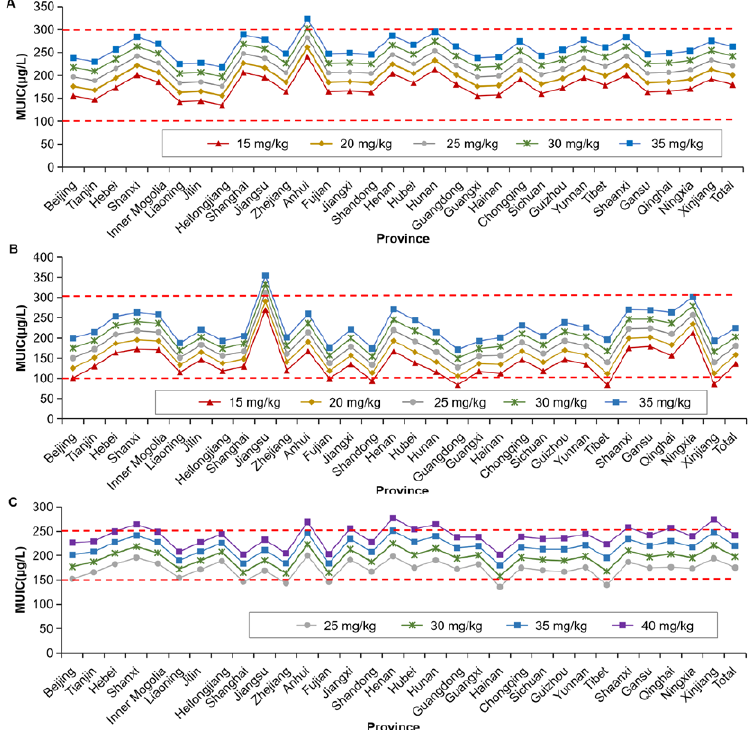
Figure 5. Evaluation by median urinary iodine concentration standard for children, adults and pregnant women under condition of the presumed different iodine content in salt. ( A ) for children; ( B ) for adults; ( C ) pregnant women. When the iodine content in salt was set as 20 mg/kg (varied from 15 to 25 mg/kg), 25 mg/kg (varied from 20 to 30 mg/kg) or 30 mg/kg (varied from 25 to 35 mg/kg), MUIC in children and adults could reach the sufficient levels. When the iodine content in salt was set as 30 mg/kg (varied from 25 to 35 mg/kg) or 35 mg/kg (varied from 30 to 35 mg/kg), MUIC in pregnant women reached sufficient levels. MUIC, median of urine iodine concentration.